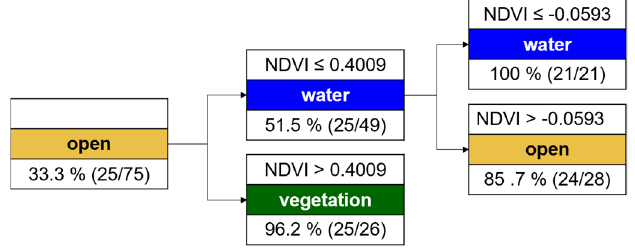
Figure A1. CART for March 2016.